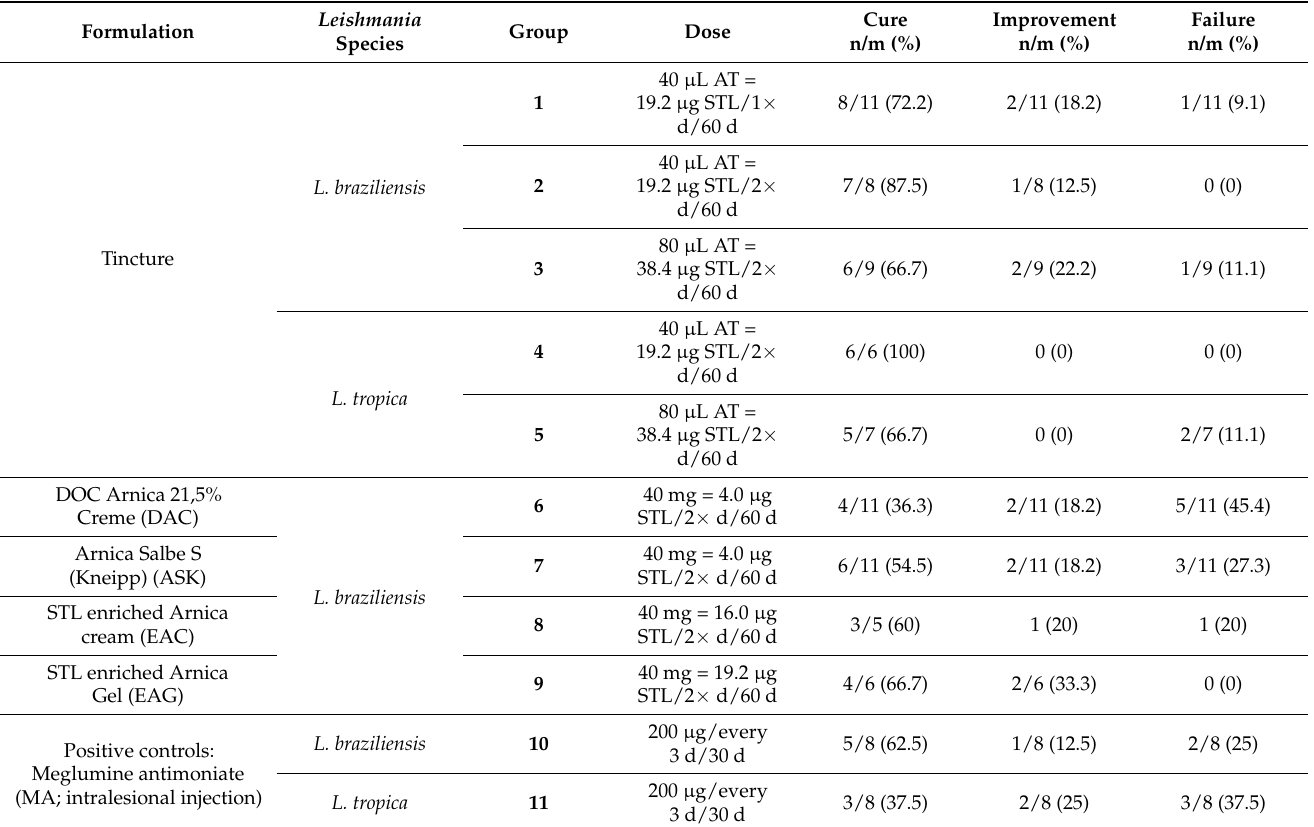
Table 3. Clinical outcome after treatment with Arnica tincture and semisolid Arnica formulations. Data represent the proportion (n animals/group size m) and percentage of hamsters for each outcome and each treatment. Cure: 100% re-epithelialization of the lesion. Improvement: any percentage reduction in lesion area. Failure: any increase in lesion size compared to baseline size. Relapse: reactivation of the lesion after initial cure during the